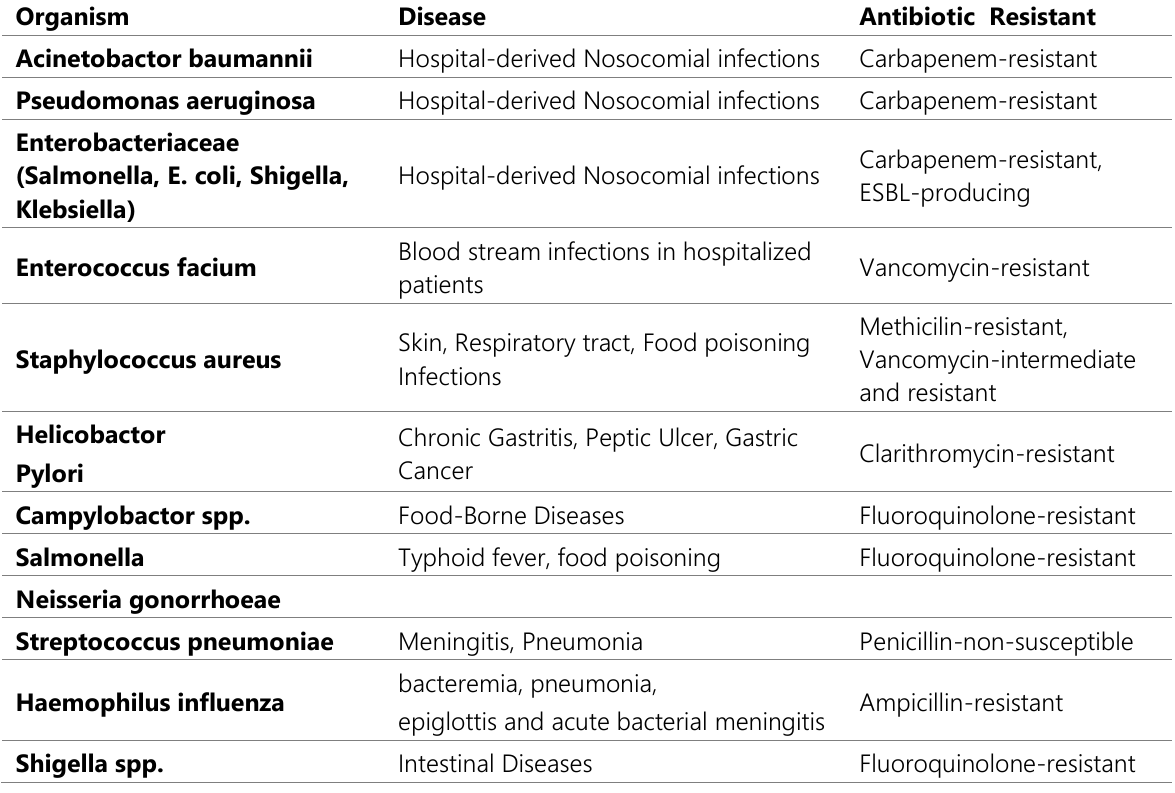
Table 1: List of Bacteria for which Antibiotics are urgently required published by WHO